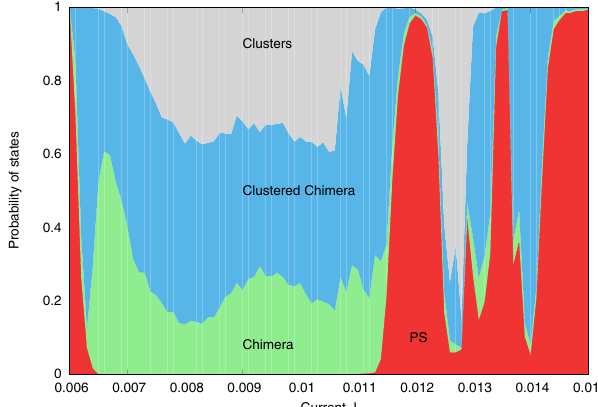
Figure 2. Stacked area chart representation of the frequency of occurrence of different states in an array of identical STOs. We show probability to observe different dynamical regimes: partial synchronization (PS, red), “chimera” (green), clustered “chimera” (blue), and clustered states (grey) starting from random initial conditions in an array of 200 STOs. Vertical extensions of the corresponding colors show the probabilities to observe the corresponding states in dependence on the parameter I . Parameters of the coupling: ε = 0.3, τ =